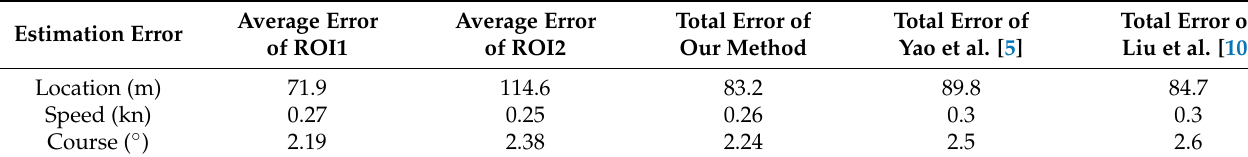
Table 2. Comparison of estimation error of motion states.